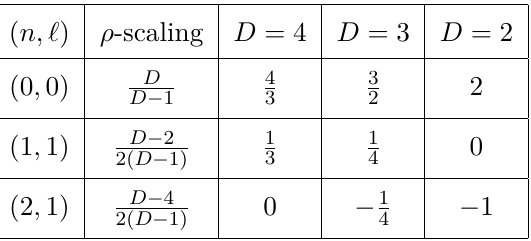
Table 1 . We show the ρ -scaling of operators of the form (2.3) which do not vanish in the large- charge limit, assuming D 6 4